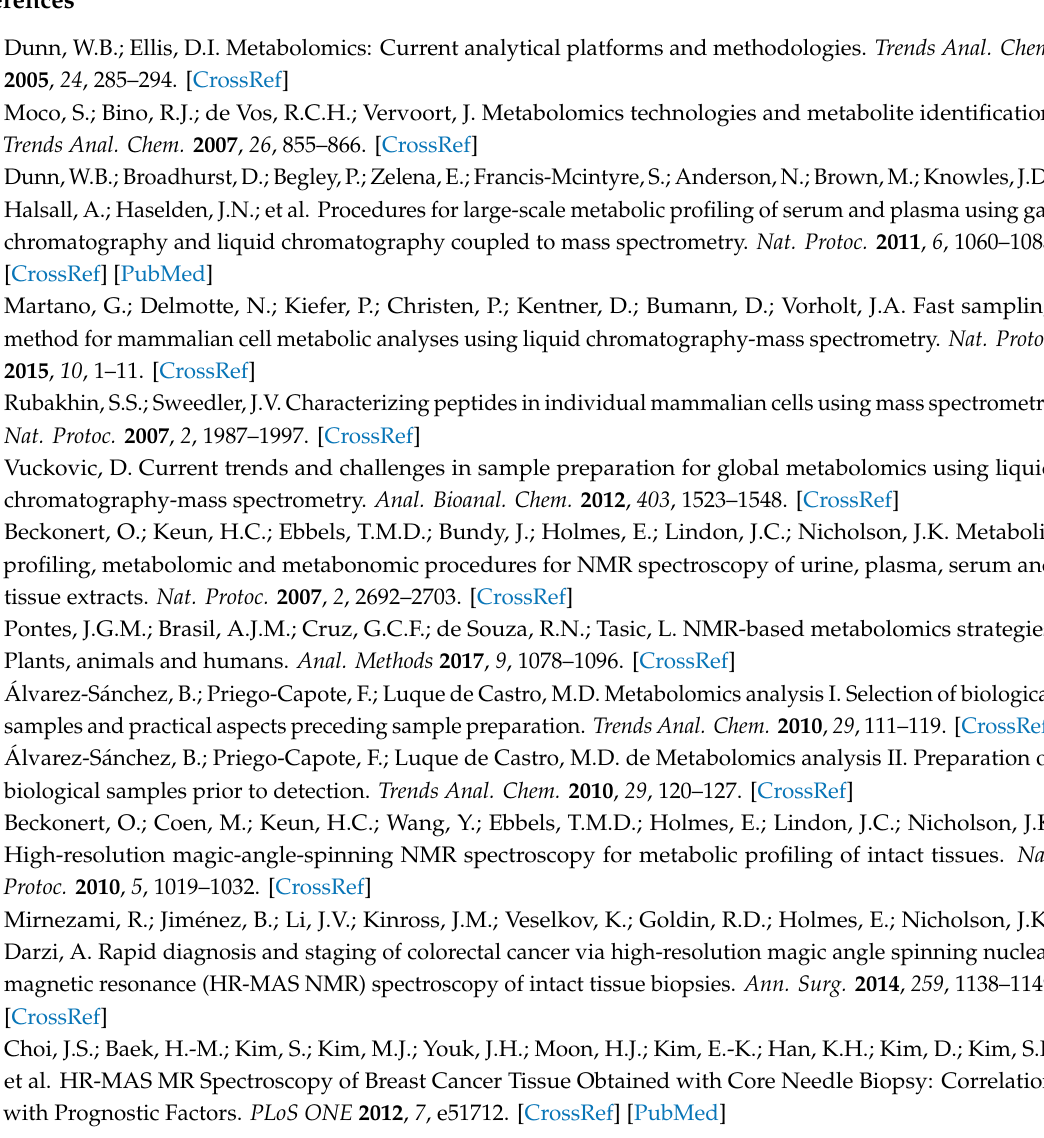
Protocol S1: Detailed preparation for the samples generating the spectra in Figure 3, Figure S1: Garlic and brain tissue displaying ethanol impurity signals. Figure S2: Di ff erences in the spectral resolution depending on the water content shown in di ff erent specimens. Figure S3: µ -rotor handling and cleaning tools. Figure S4: Example of spectrum obtained by adding a known amount of sucrose embedded in a brain tissue